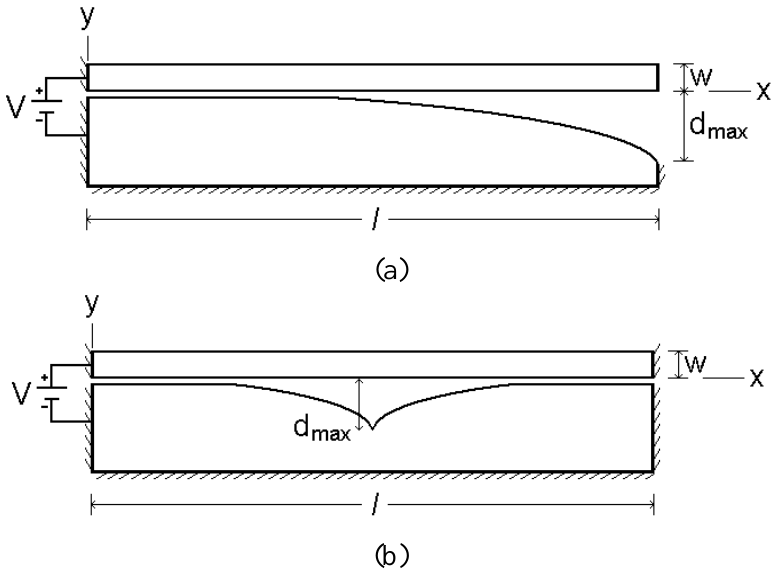
Figure 10. Polynomial beam profiles (a) cantilever beam (b) fixed-fixed beam.